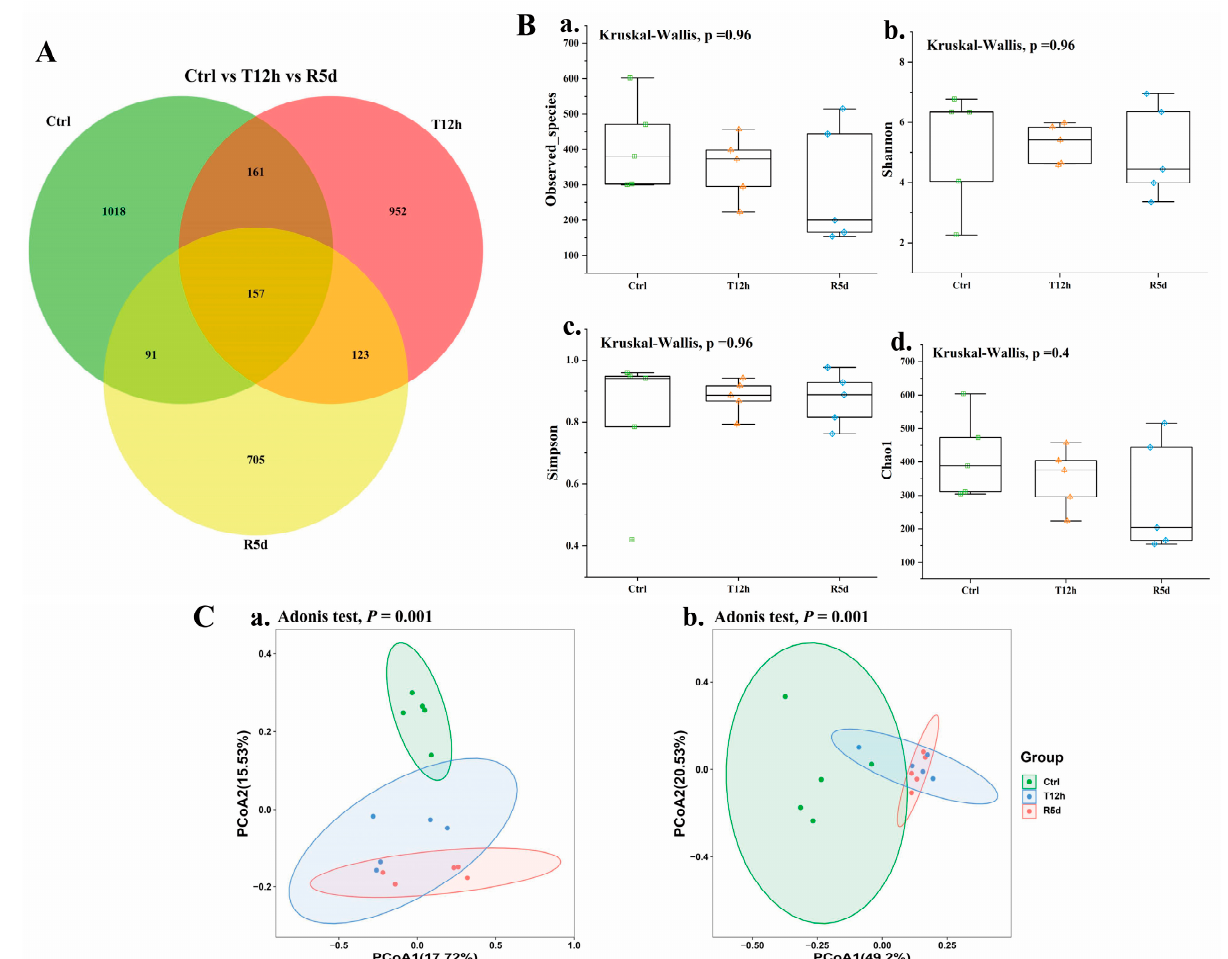
Figure 4. ( A ) Common and unique operational taxonomic units (OTUs) displayed by Venn diagram in the control, 12 h transport and recovery groups. The overlap indicates shared OTUs ( B ) and alpha and beta diversity of the gut microbiomes of juvenile largemouth bass under transport stress.